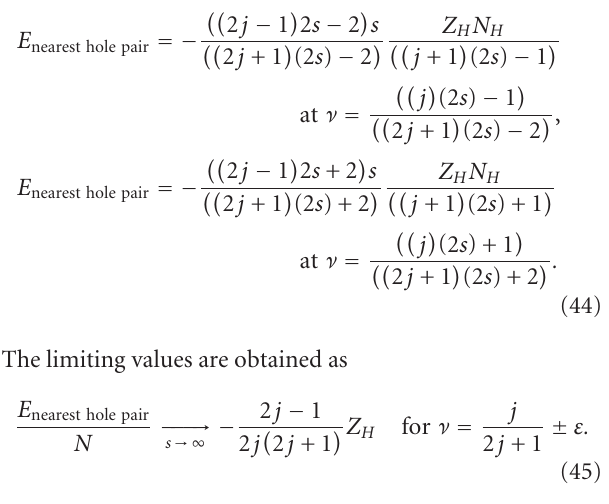
3.3. Gap Structure at ν = j/ (2 j + 1) . We draw the most uni- form electron configuration at ν = j/ (2 j + 1) in Figure 11. Therein, solid lines indicate the Landau orbitals filled with electron, and dashed lines indicate the vacant Landau orbitals. Nearest hole pairs are red coloured, and single holes are blue coloured. The Coulomb transitions from the nearest hole pair AB are drawn by black arrows in Figure